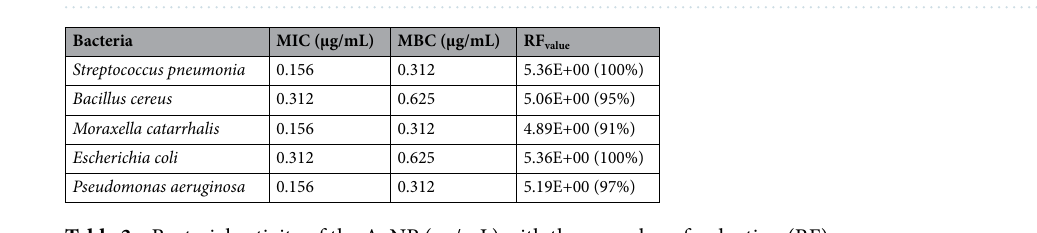
Table 3. Bacterial activity of the AgNP (µg/mL) with the mean log of reduction (RF).